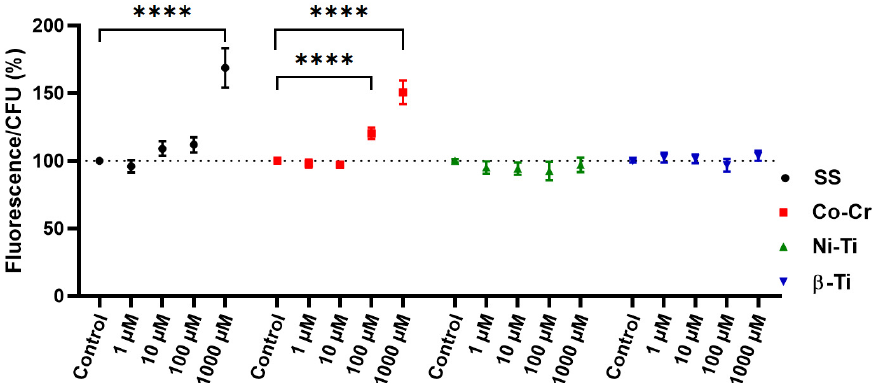
Figure 2. Ratio between the intensity of the fluorescence signal and CFU after treatment of yeast cells with different metal ion mixtures and concentrations. The percentage ratio of fluorescent dye intensity and the yeast CFU value were used to compare the intracellular oxidation of the treated viable cells to the untreated control sample, which was set at 100%. Means with the 95% confidence interval are shown, and the statistically different measurements are labeled with * (* p < 0.05, ** p < 0.01, *** p < 0.001, and **** p < 0.0001). *** p < 0.001, and **** p <